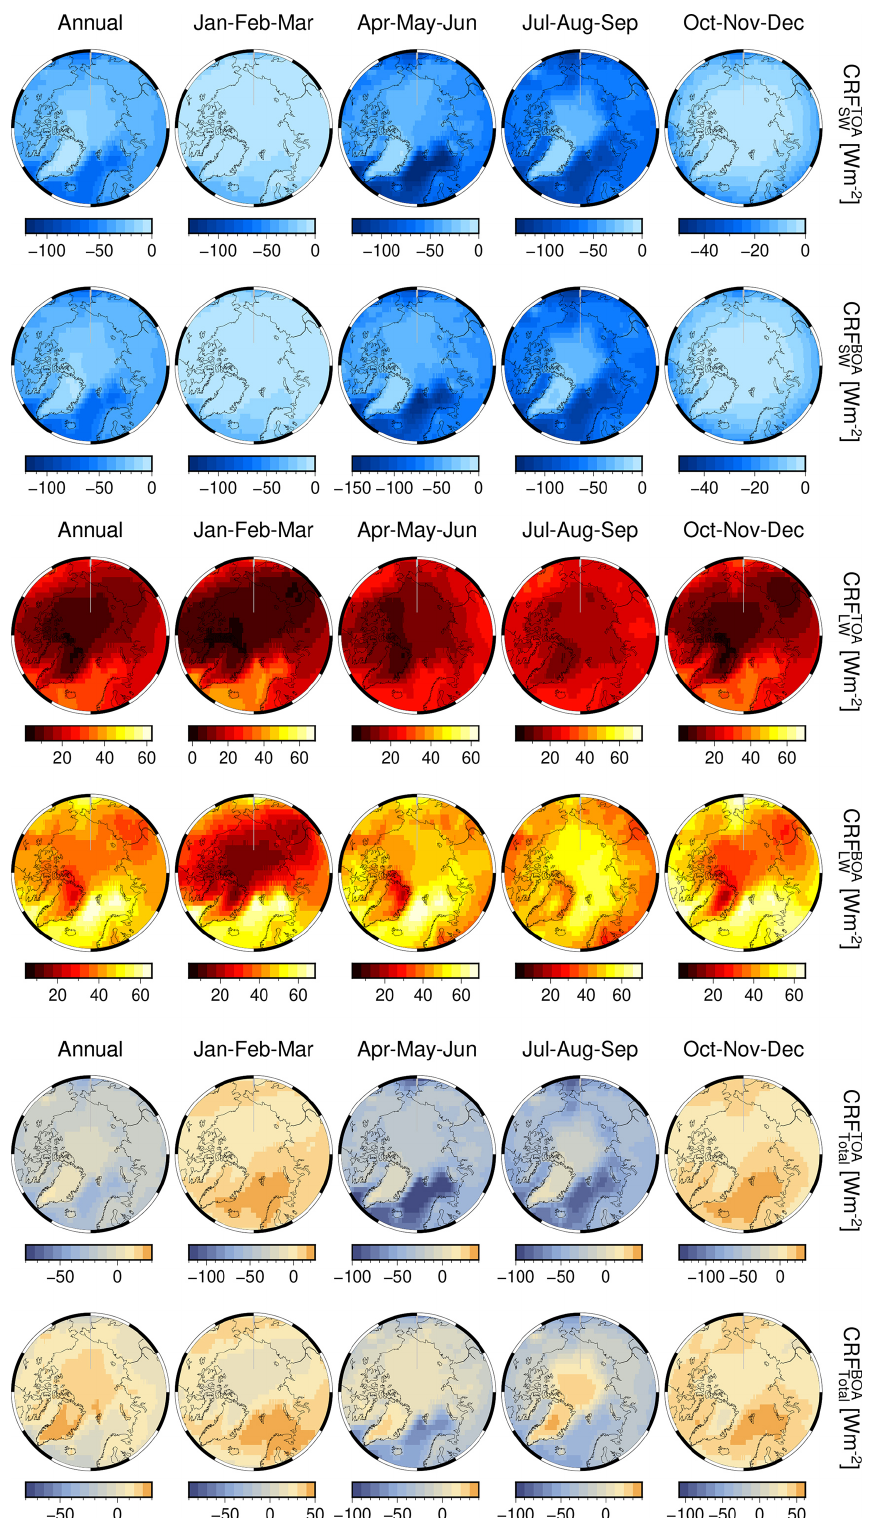
Figure G1. From left to right, annual and seasonal average values of SW (rows 1–2), LW (3–4), and total (5–6) cloud radiative forcing (CRF, Wm − 2 ) at TOA and BOA, respectively. Note the different color scales to match the CRF ranges.